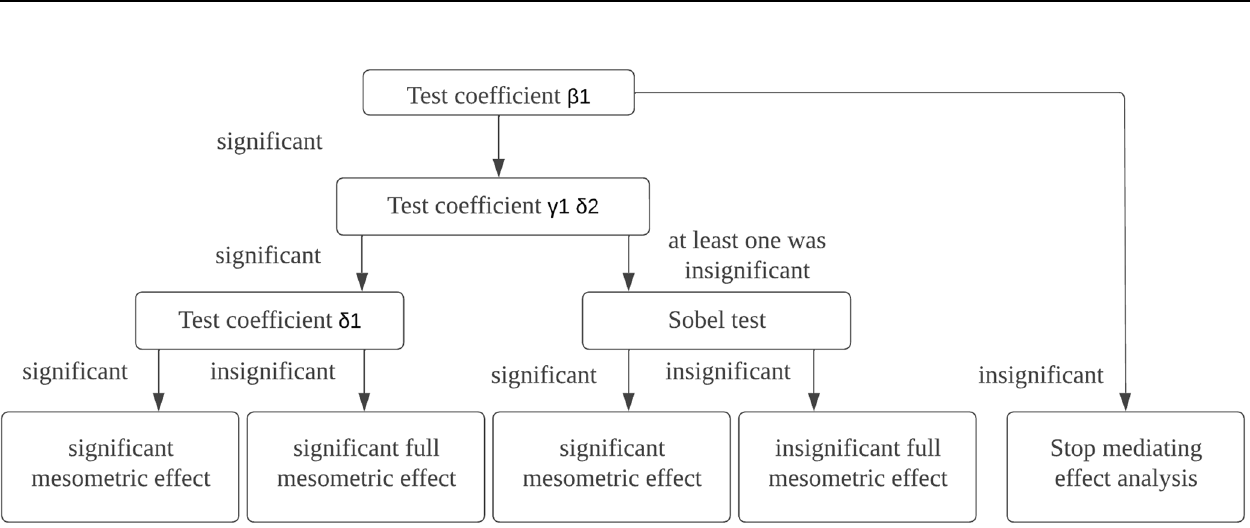
Fig. 2 Intermediary effect test program diagram. For the test of mediating effects, the coef fi cient β 1 in Model (1) is fi rst tested to see if it is signi fi cant. If signi fi cant, the aggregate effect is present. Next, the coef fi cients γ 2 and δ 2 are tested using the stepwise method (Baron and Kenny, 1986; Wen et al., 2004). If both are signi fi cant, then a mediating effect exists. However, it is important to note that the power of the stepwise method is low. That is, the actual product of γ 2* δ 2 is signi fi cant, while the sequential test may not be signi fi cant (Fritz and Mackinnon, 2007; Mackinnon et al., 2002). Therefore, if at least one of the tests is insigni fi cant using the stepwise method, the Bootstrap or Sobel test should be continued to test the coef fi cient product ’ s